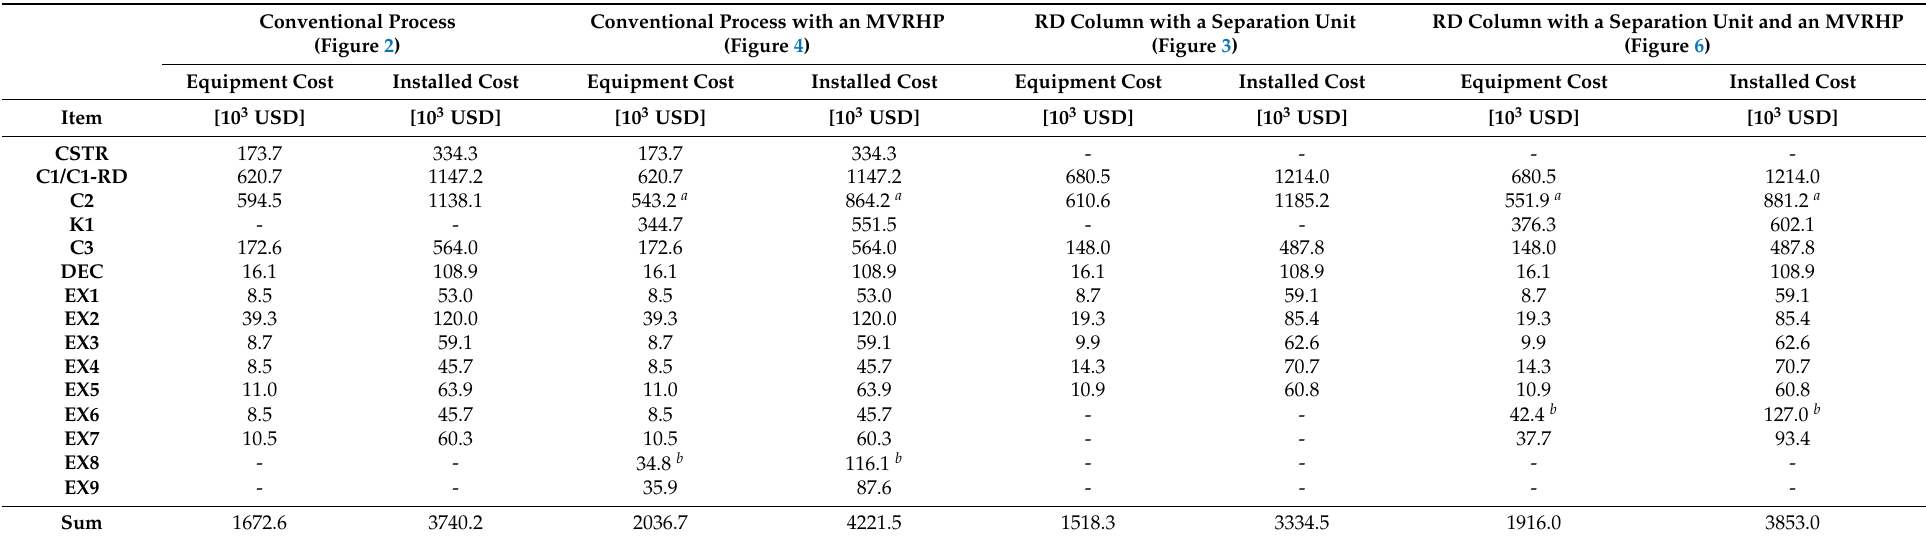
Table A5. Equipment cost and total installed cost of individual